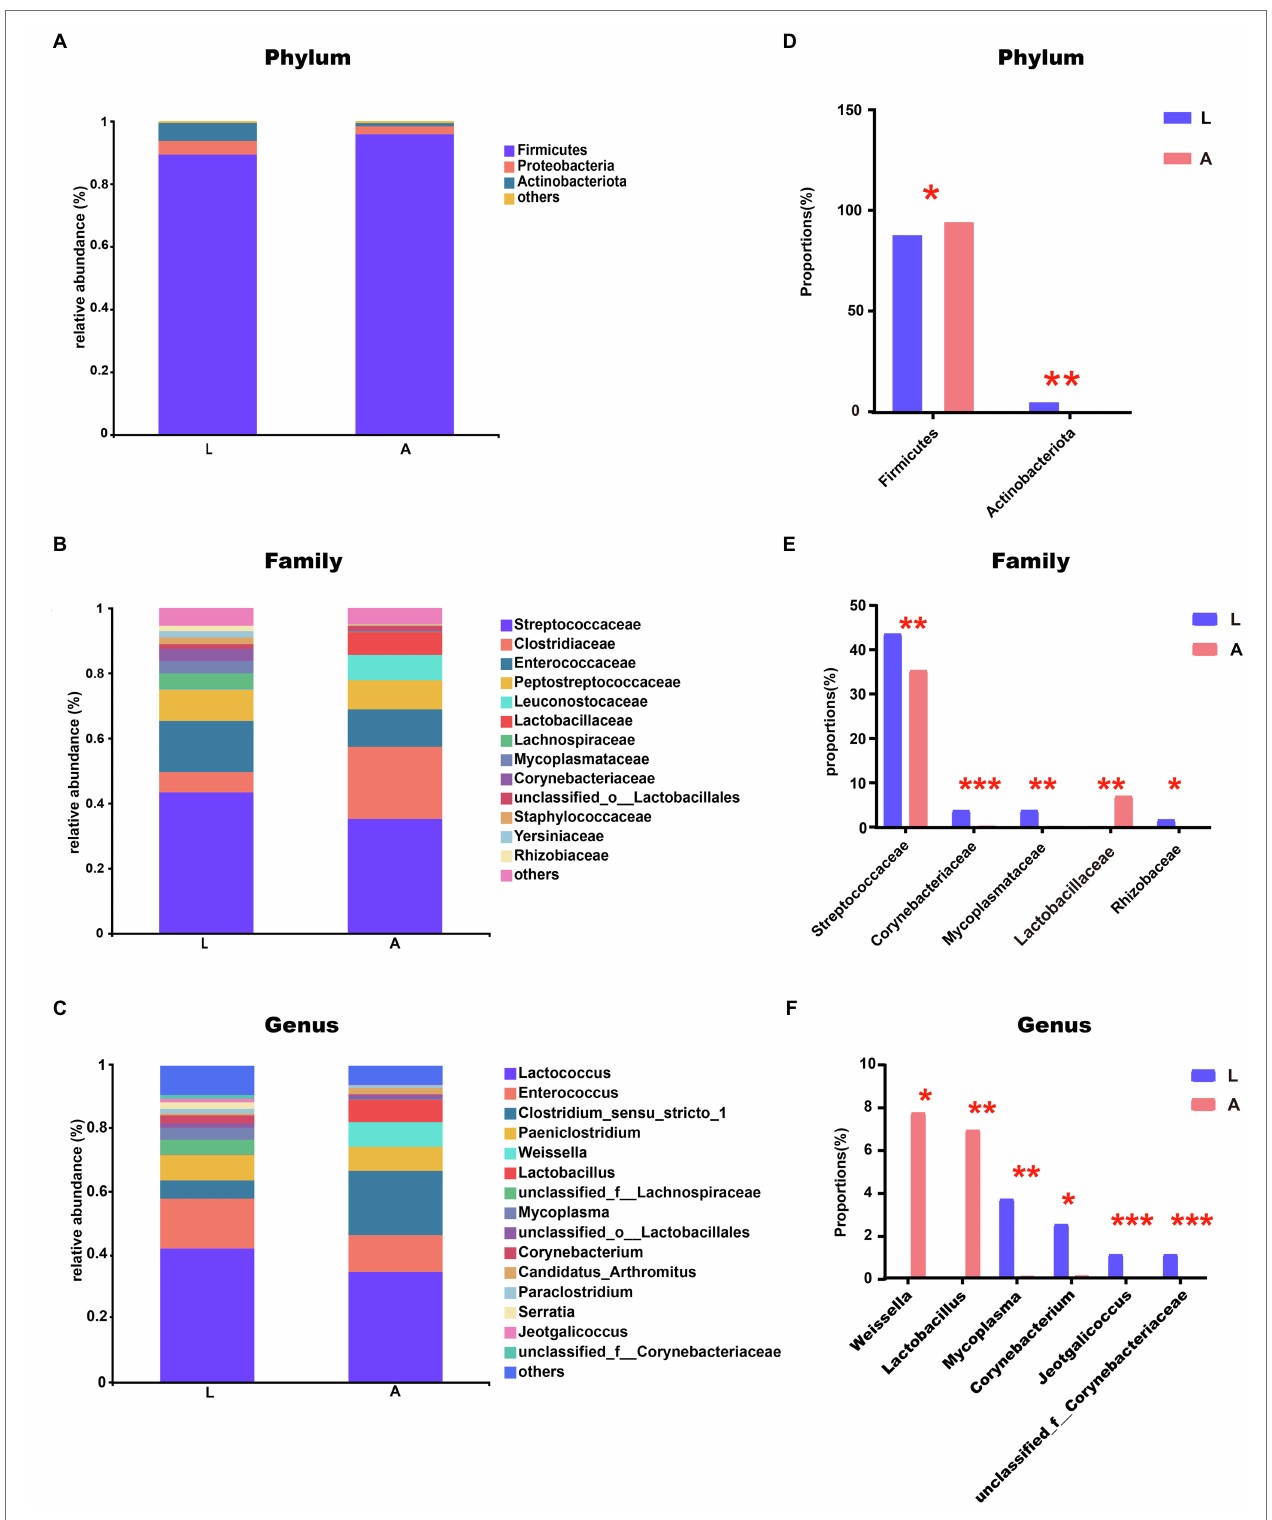
FIGURE 4 | (A–C) Relative abundance of major taxa in microbiotas of the bat gut: (A) Phylum level, (B) Family level, and (C) Genus level. (D–F) Analysis of gut microbial community differences: (D) Analysis of phylum-level differences, (E) Analysis of family-level differences, and (F) Analysis of genus-level differences (*0.01 < p ≤ 0.05, **0.001 < p ≤ 0.01, and *** p ≤